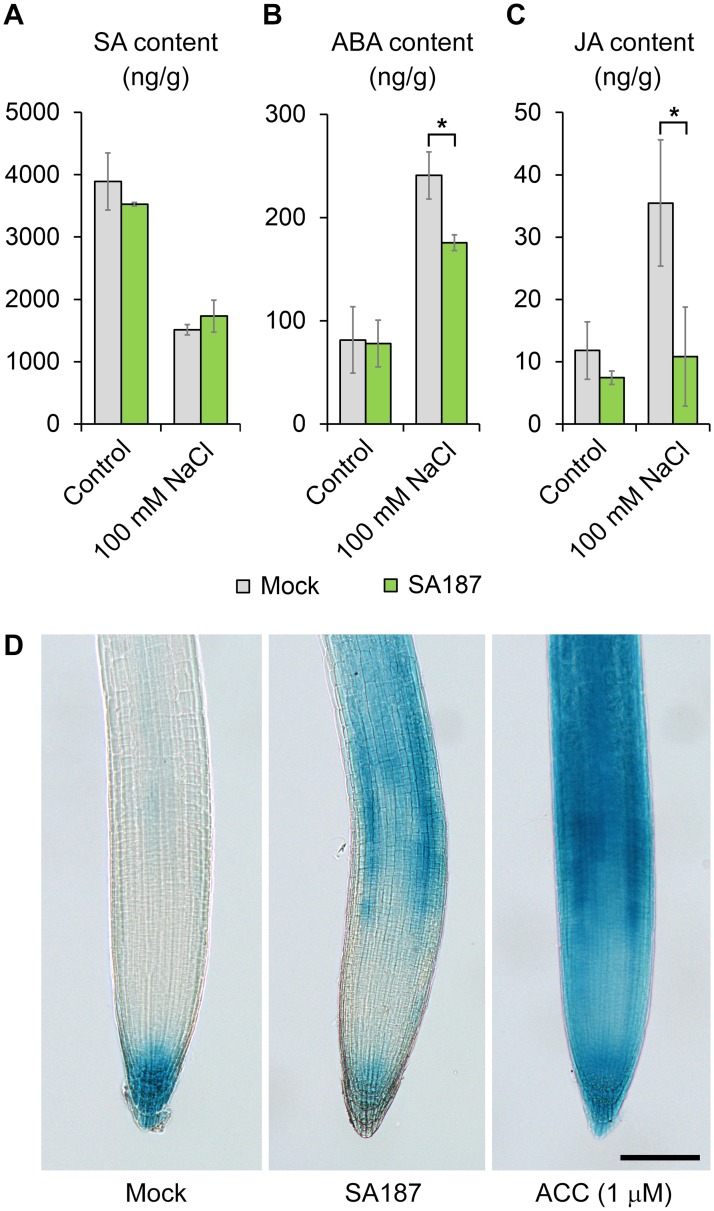
SA187 modulates abscisic acid, jasmonic acid, and ethylene hormonal pathways under salt stress.(A) Salicylic acid (SA), (B) abscisic acid (ABA) and (C) jasmonic acid (JA) content in mock- and SA187-inoculated plants after growth on ½ MS with or without 100 mM NaCl for 12 days. Error bars indicate SE, based on three biological replicates. Asterisks indicate a statistical difference based on the Mann-Whitney test (* P < 0.05). (D) The ethylene reporter, pEBF2::GUS, visualizing the relative ethylene content in primary root tips of mock- and SA187-inoculated, and ACC-treated 7-day-old seedlings under normal conditions (salt stress conditions provided similar results). Bar = 100 μm.